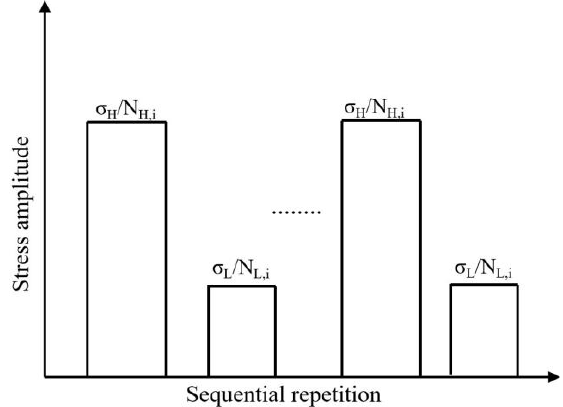
Figure 2. Repeated high/low two-step loading procedure.